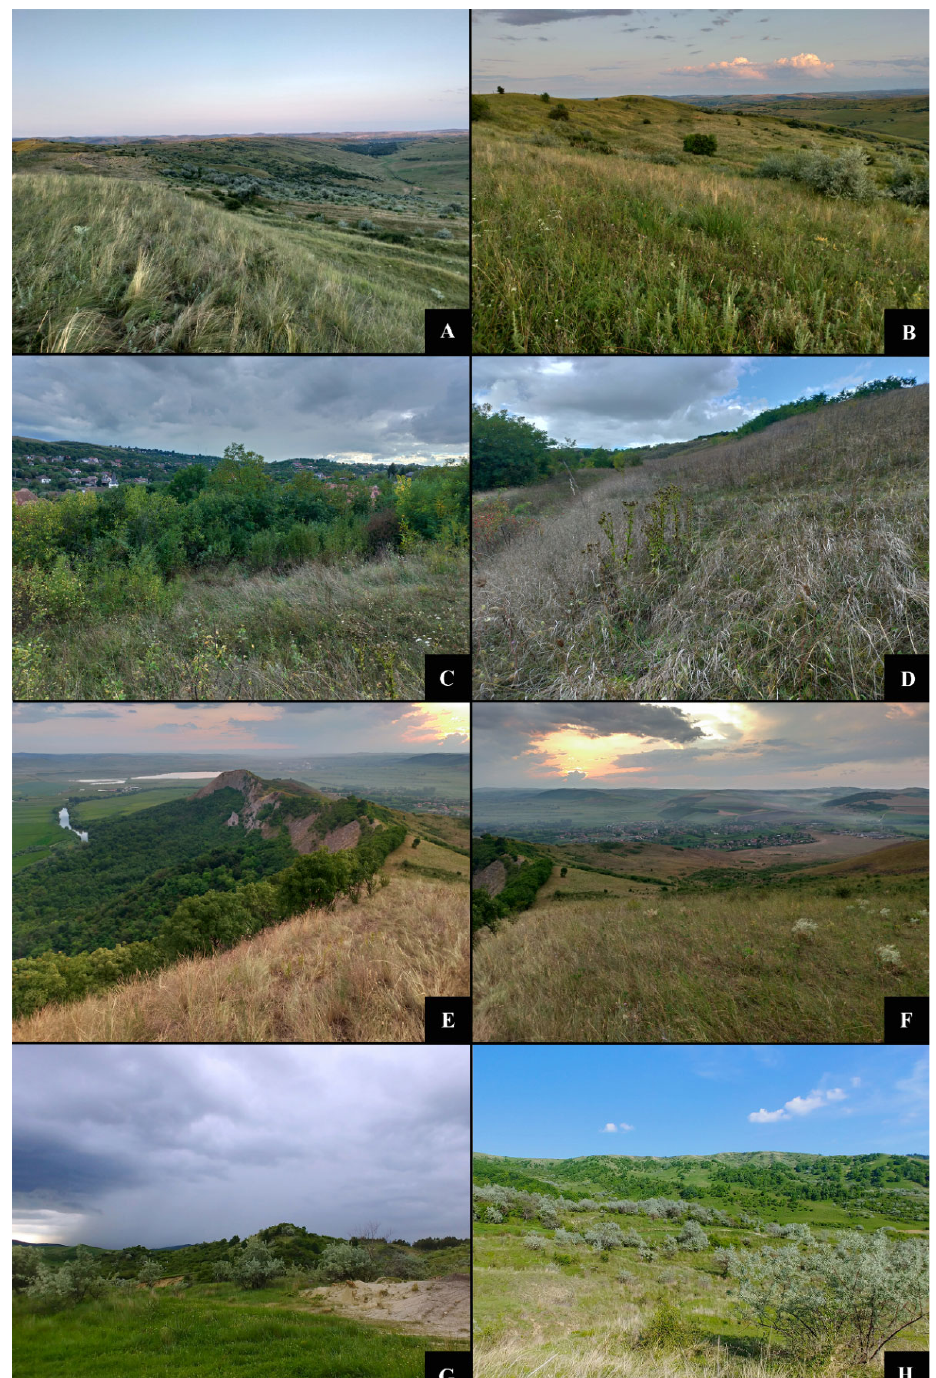
Figure 5. The habitat in sample locations: ( A , B ) The Natura 2000 protected area ROSCI0295 Dealurile Clujului Est (Jucu de Sus); ( C , D ) The Natura 2000 protected area ROSCI0238 Suatu–Cojocna–Crairât (Cojocna); ( E , F ) The Natura 2000 protected site ROSCI0210 Râpa Lechin ț a; ( G , H ) The Natura 2000 protected area ROSCI0272 Vulcanii Noroio ș i from Pâclele Mari and Pâclele Mici.